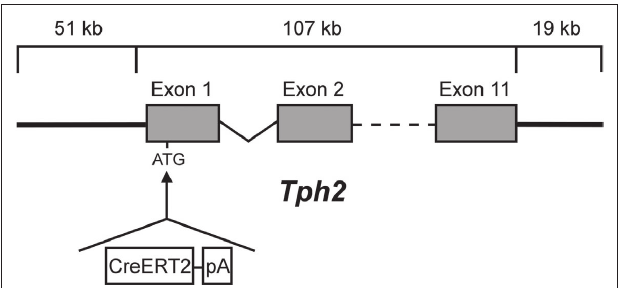
FIGURE 2 | X-Gal staining of R26R TPH2-CreERT2 mice is restricted to the brain stem and midbrain where raphe nuclei are located. (A–C,J–L) Line 1.38. (D – F) Line 1.35. (G–I) Line 1.21. (A–I) Mice treated with tamoxifen ( + Tx) (1 mg twice daily for 5 days) show abundant X-Gal staining at all levels of raphe nuclei. (J–L) Vehicle ( + Ve) treated mice show nonsignifi cant X-Gal staining. (A,D,G,J) Median raphe nuclei; (B,E,H,K) dorsal raphe nuclei; (C,F,I,L) caudal raphe